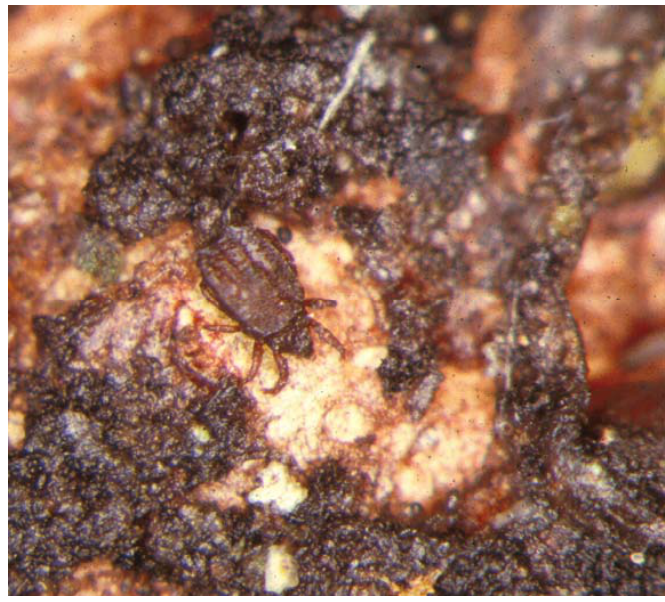
Figure 1. An old ‐ growth canopy specialist, the oribatid mite, Camisia carrolli , feeding on canopy detritus in old ‐ growth canopy in the Pacific Northwest.